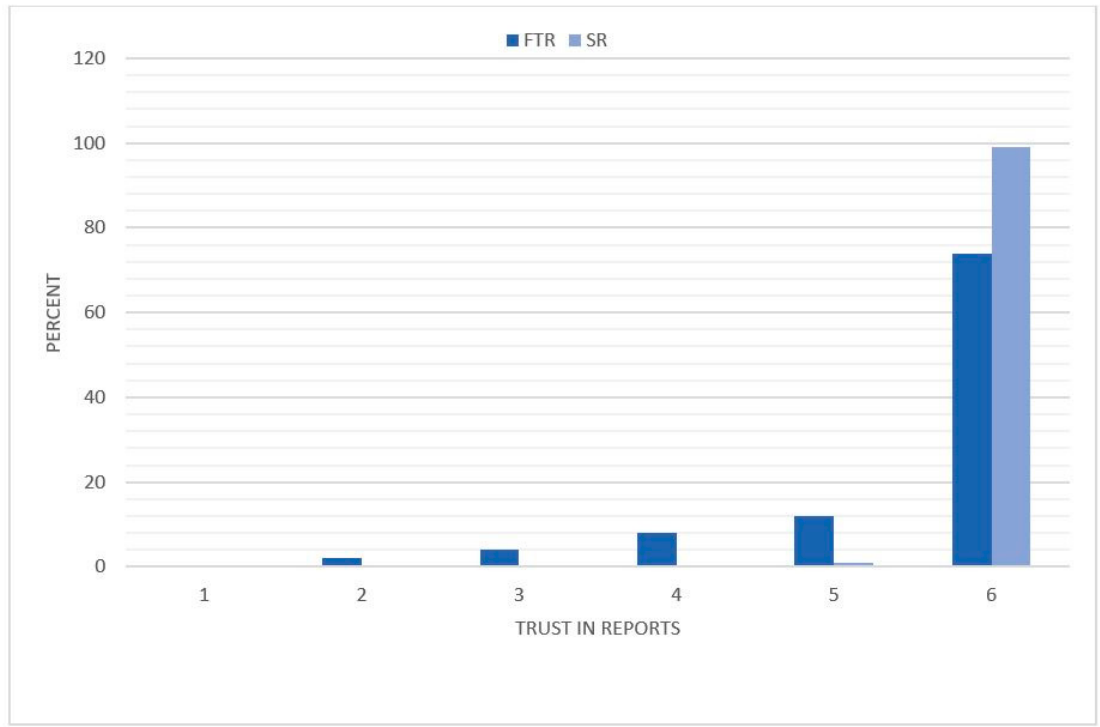
Figure 5. Distribution of the referring physicians’ trust in the report. The reviewers rated the reports based on a Likert scale with a range from 1 to 6 (1 = insufficient, 6 = excellent). The degree of the referring physician’s trust is illustrated on the x -axis and the percentage distribution on the y -axis. FTR = free text reports; SR = structured reports.